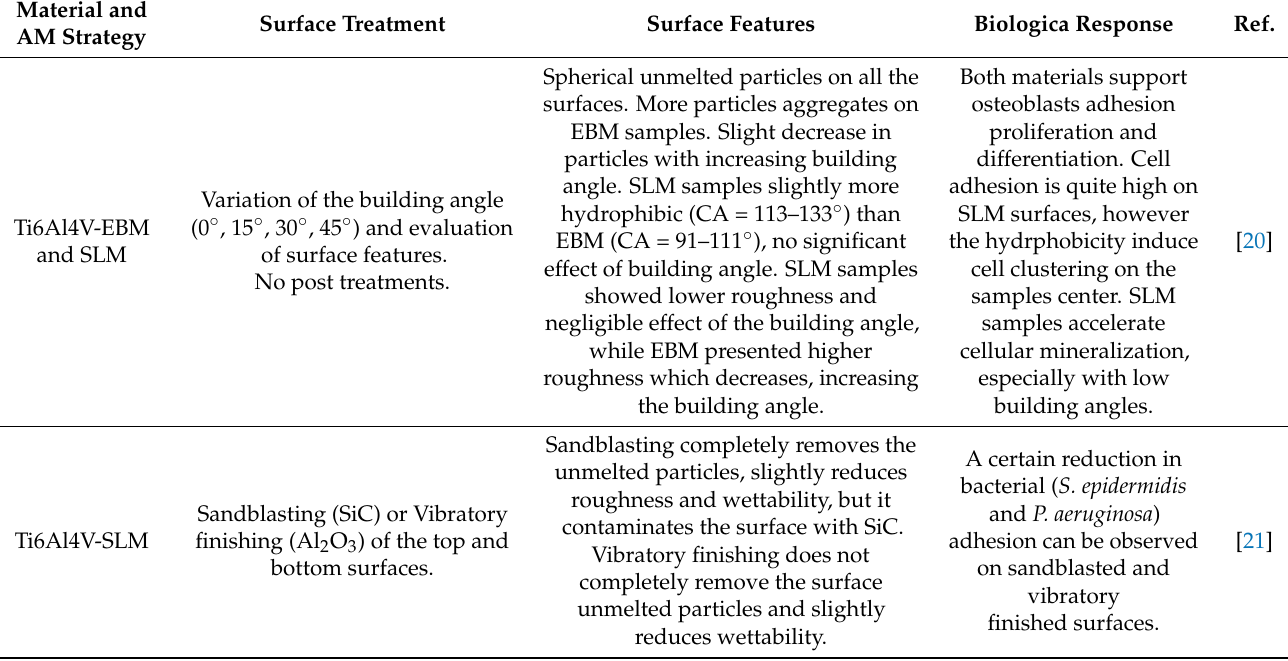
Table 1. Surface modifications of AM Ti-based materials for bone contact